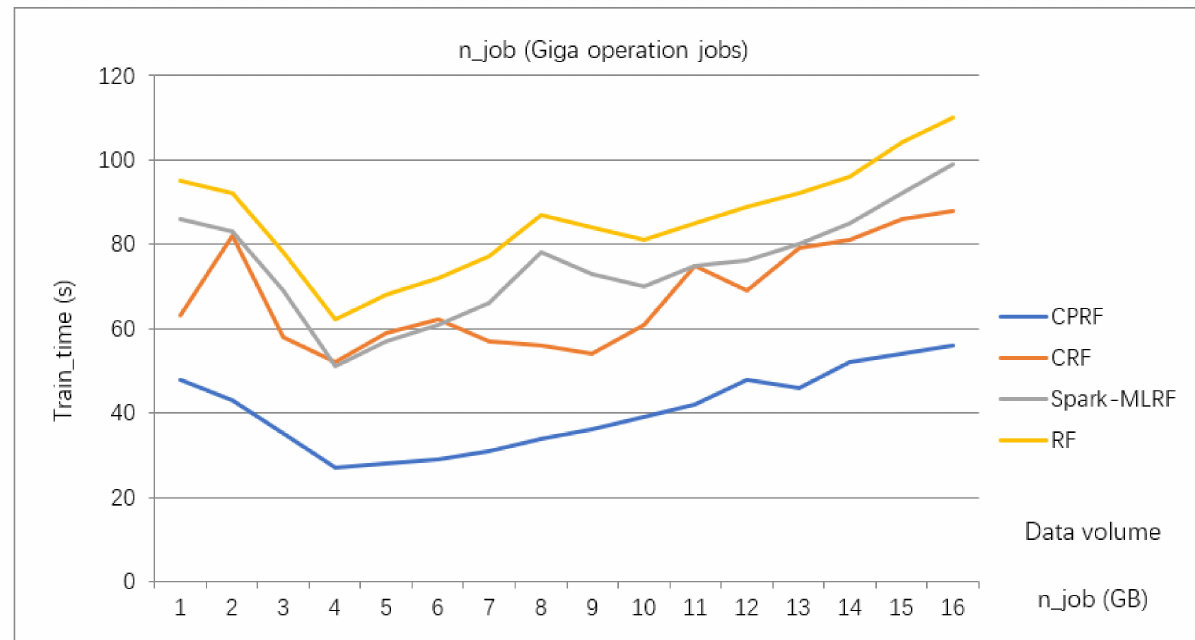
Figure 7. Train_time along with the job quantity of CPRF and other